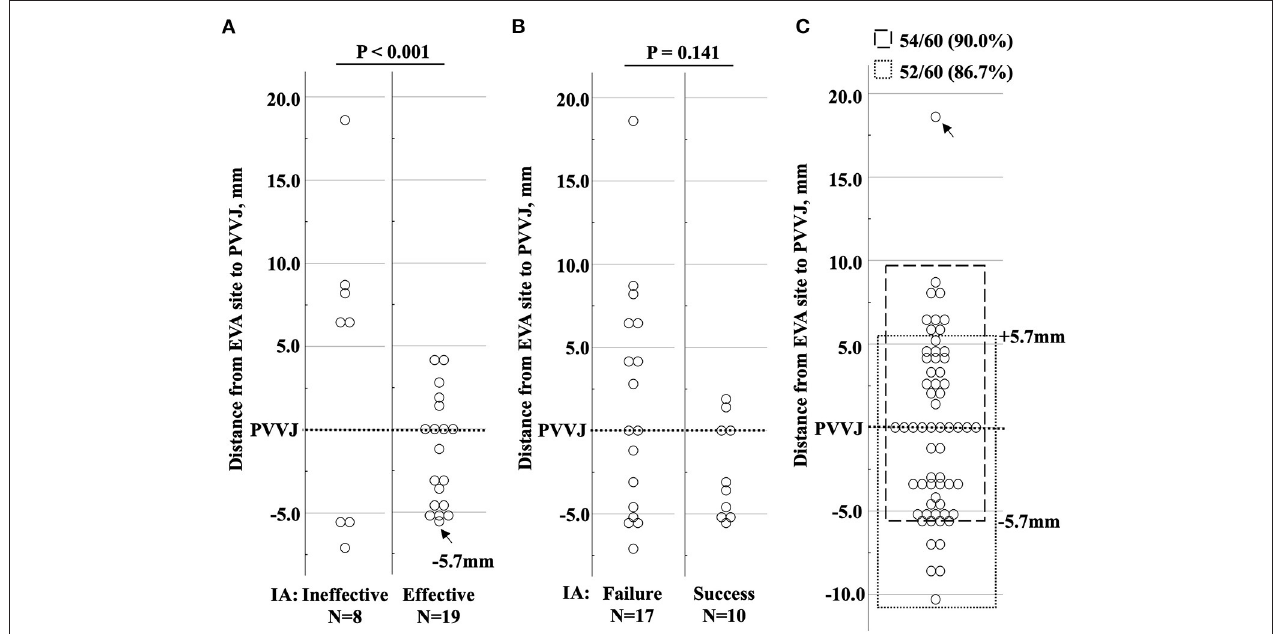
FIGURE 6 | Distribution of the EVA sites in patients who had non-ipsilateral-matching IA. (A) The circles denote the EVA sites with ineffective and effective IA. Effective ablation was defined as suppression of VA within 10s of radiofrequency energy delivery. The black arrow marks the farthest EVA site to PVVJ ( − 5.7mm) with effective ablation. (B) The circles denote the EVA sites with IA success and failure. (C) The circles denote the EVA sites in total patients. The EVA site (black arrow) in PA was excluded. The dashed box denotes the EVA sites located from − 5.7mm to 10.0mm, estimating that 54/60 (90.0%) patients could have effective ablation by supravalvular strategy. The dotted box denotes the EVA sites from RVOT to + 5.7mm above PVVJ, estimating that the subvalvular strategy could have effective ablation in 52/60 (86.7%) patients. EVA, earliest ventricular activating; IA, initial ablation; PA, pulmonary artery; PVVJ, pulmonary valve–ventricle junction.